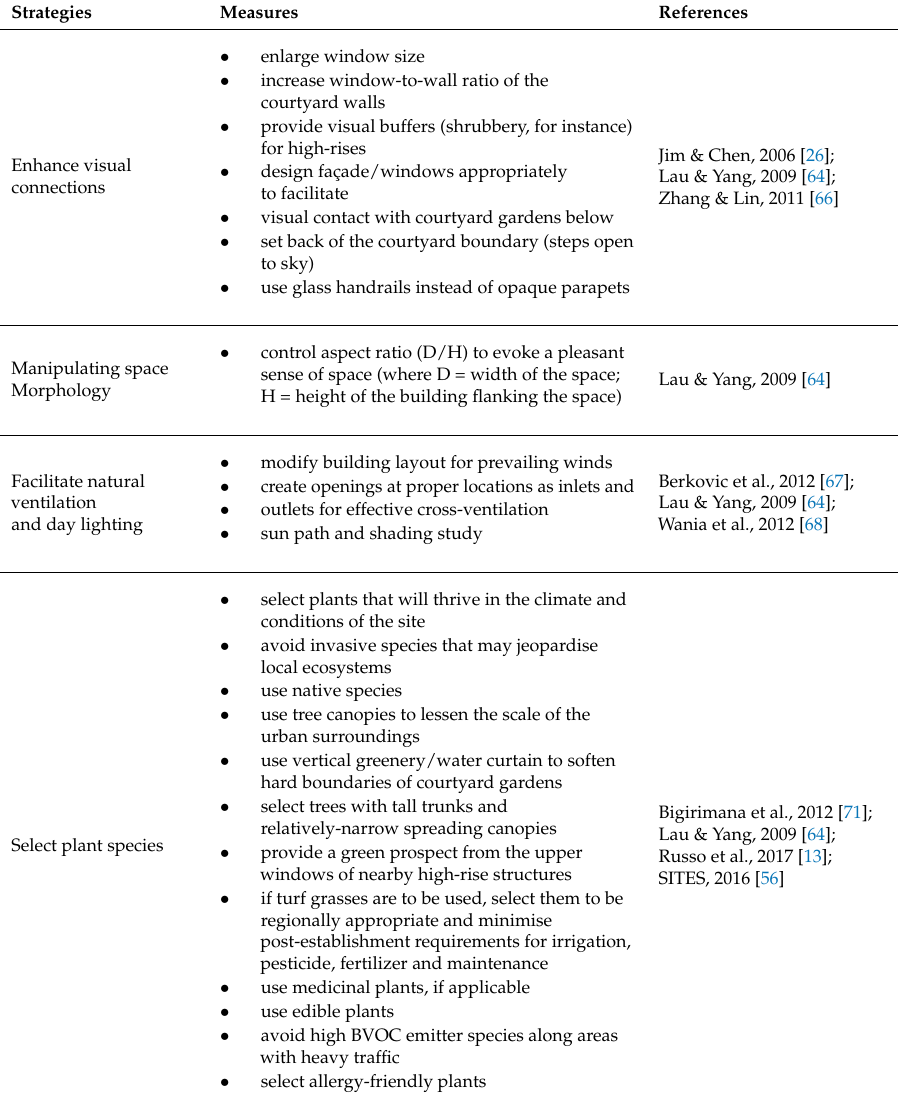
Table 2. Compact cities site-specific performance benchmarks and design strategies and